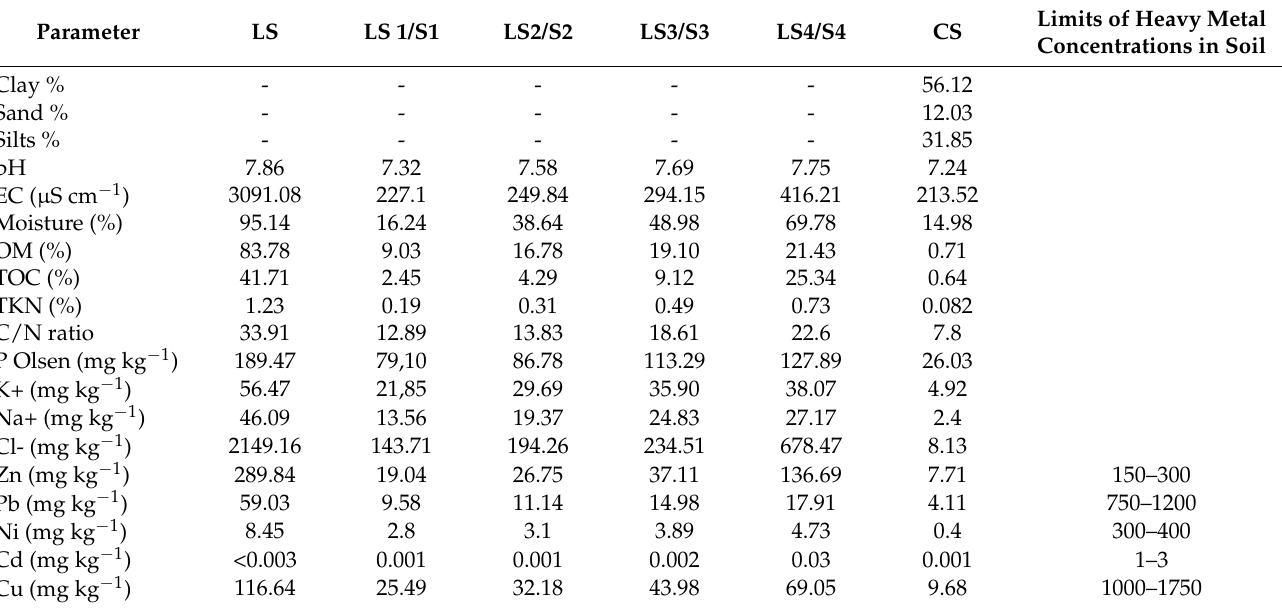
Table 1. Physio-chemical properties of experimental soils and liquid sludge from the treatment plant in Skhirat, Rabat,